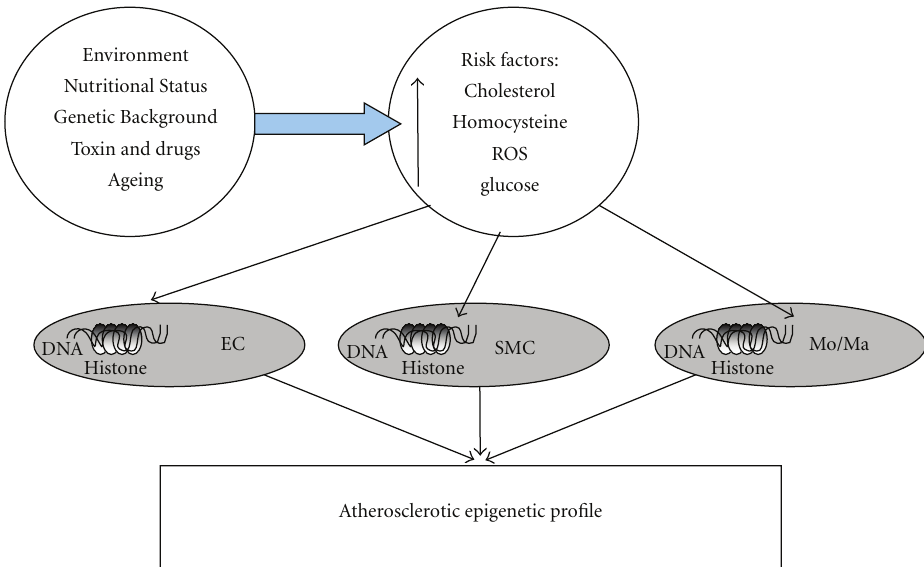
Figure 3: Factors such as nutritional status and genotype have been involved in the presence of risk factors, which not only activate biochemical pathways that lead to cellular dysfunction, but also can alter epigenetics tags on DNA and Histone. The sum of epigenetic modifications in the vascular cells will result in an atherosclerotic epigenetic profile. ROS: reactive oxygen species; EC: endothelial cell; SMC: smooth muscle cell; Mo/Ma: